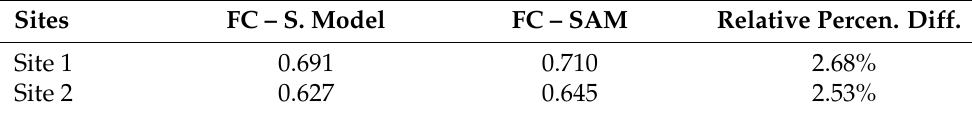
Table 10. Relative percentage difference of the capacity factor between simulations. Sites FC – S. Model FC –